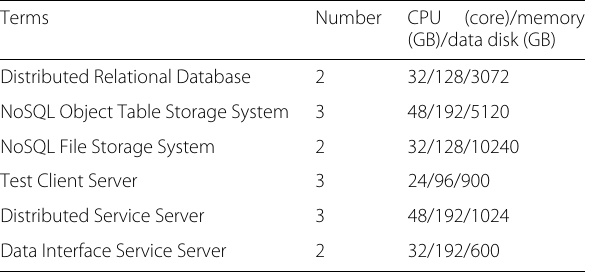
Table 1 The parameters of cloud